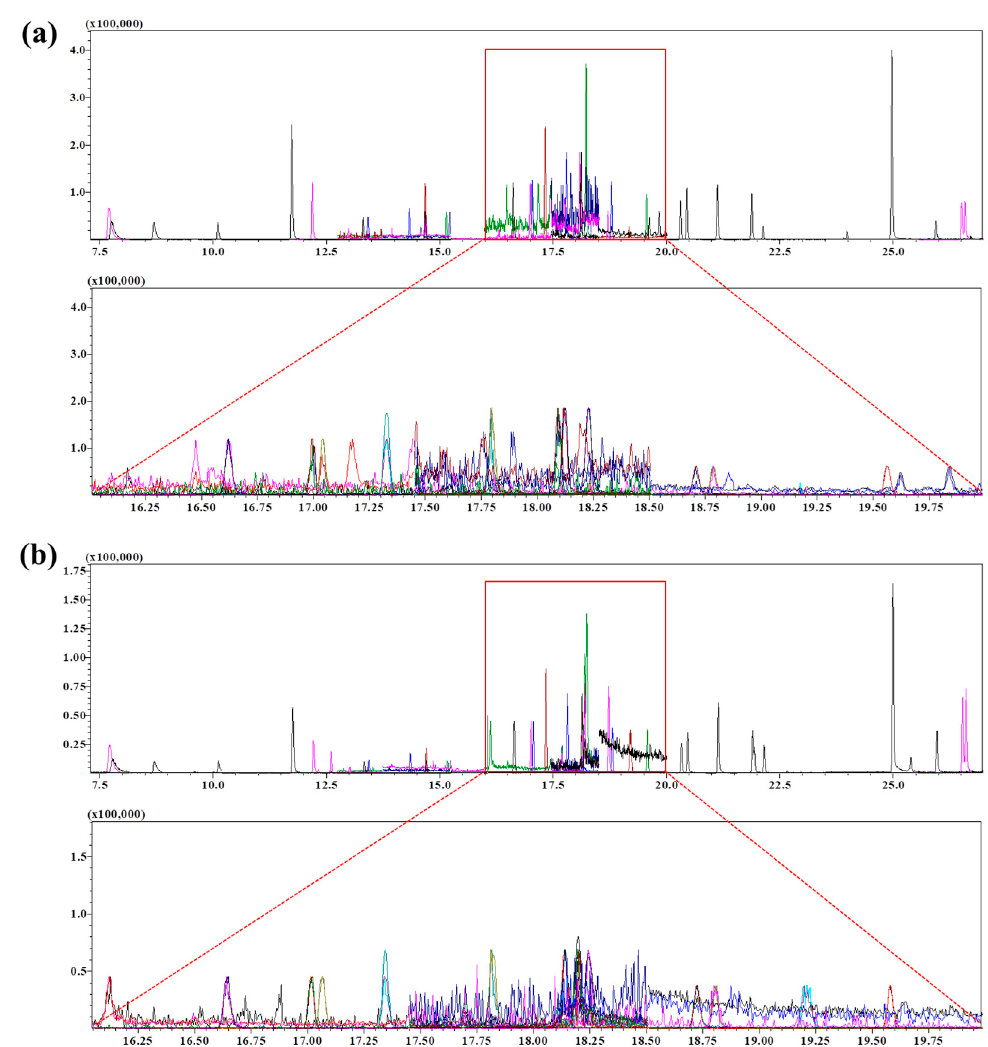
Figure A1. Comparison of the TICs for the 32 compounds in beef, which were obtained using the ( a ) dSPE, and ( b ) C 18 SPE for the cleanup step.